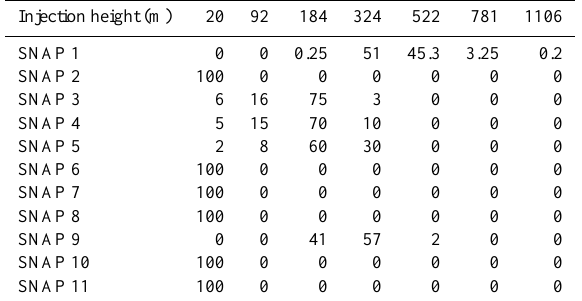
Table 1. Vertical emissions profiles (%) for each SNAP category. Injection height (m)